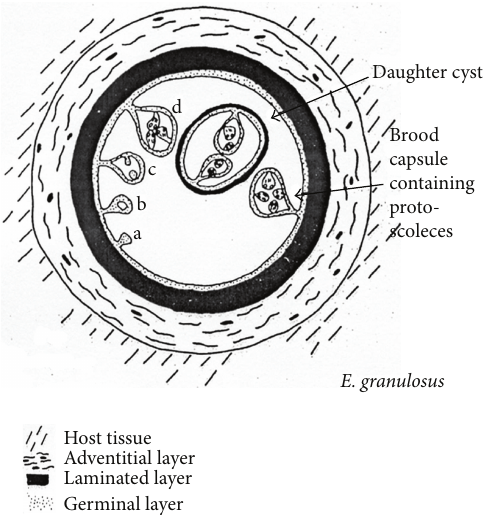
Figure 4: Cyst’s structure from WHO/OIE Manual on Echinococcosis in Humans and Animals: A Public Health Problem of Global Concern, edited by J. Eckert, M. A. Gemmell, F. X. Meslin, and Z. S. Pawłowski.